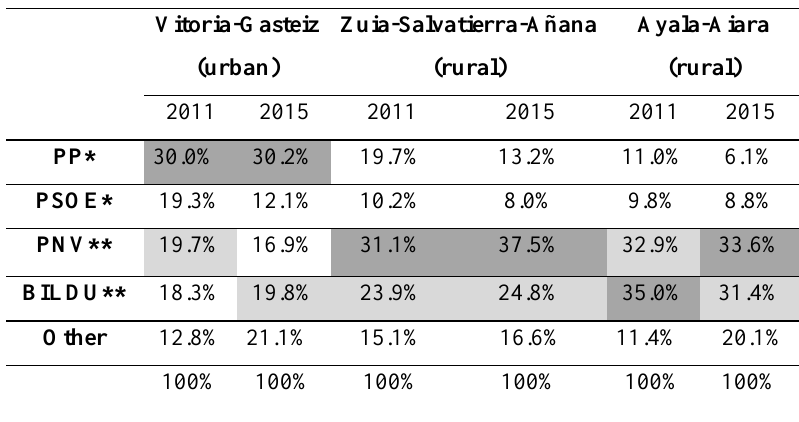
Table 1. Local Vote in Municipal Elections (2011-2015) (urban/rural